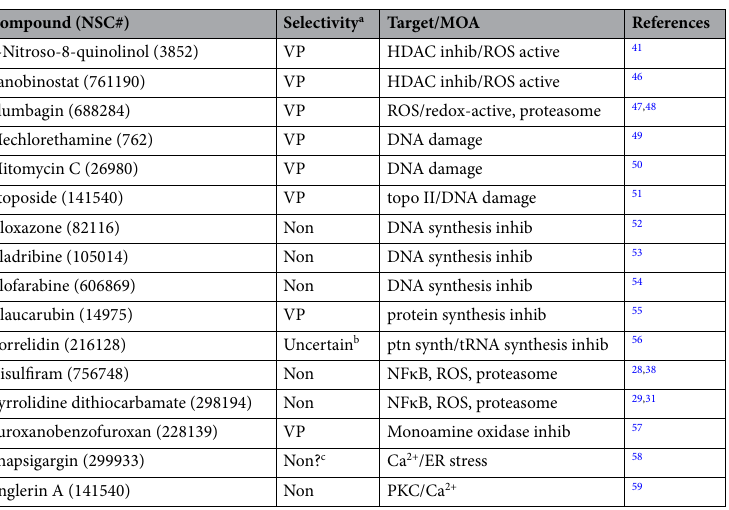
Table 3. Active compounds with putative known targets or mechanisms of action. a Based on average IC 50 for VP and VN cell lines. b IC 50 could not be calculated for VP cell lines. c Incomplete loss of cell viability at highest